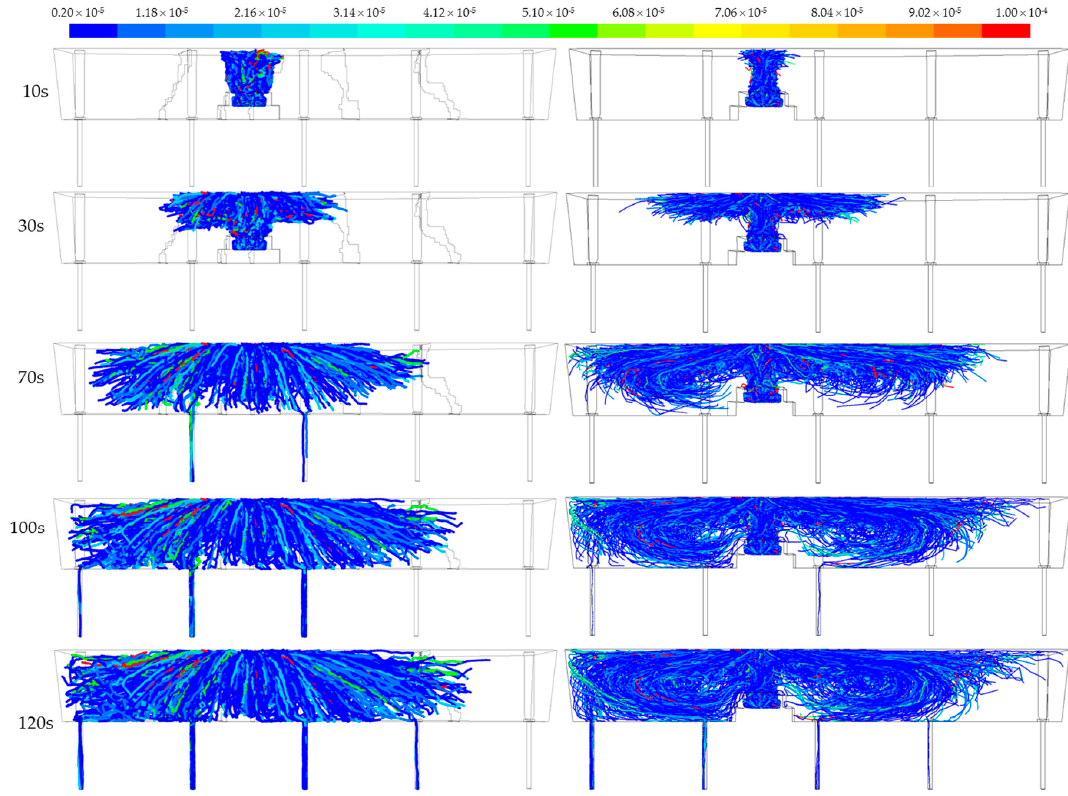
Figure 10. Comparison of inclusion trajectory for tundish configuration with M1 and M2.